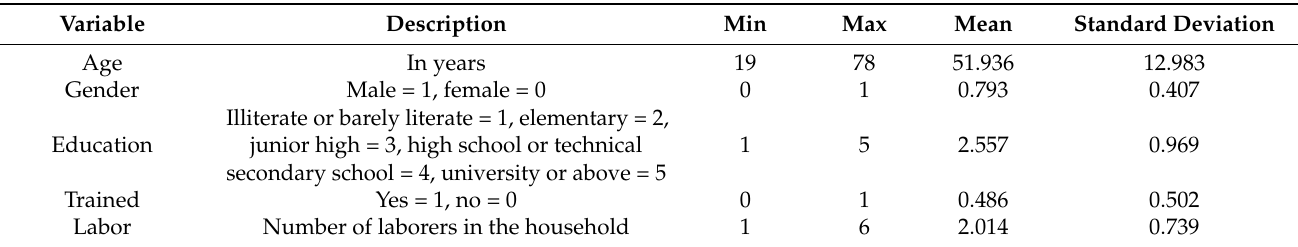
Table 2. Basic characteristics of the